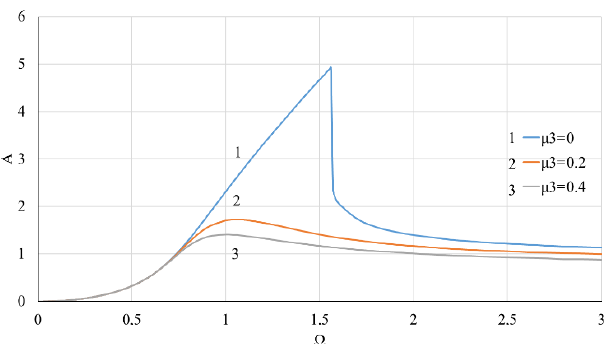
Figure 12. Dependence of the vibration amplitude A on the rotor velocity (cid:127) with nonlinear stiffness coefficient of the support K 3 = 0 . 1 at value of the coefficient of linear viscous damping µ 1 = 0 . 1 and various values of nonlinear viscous damping coefficient µ 3 .